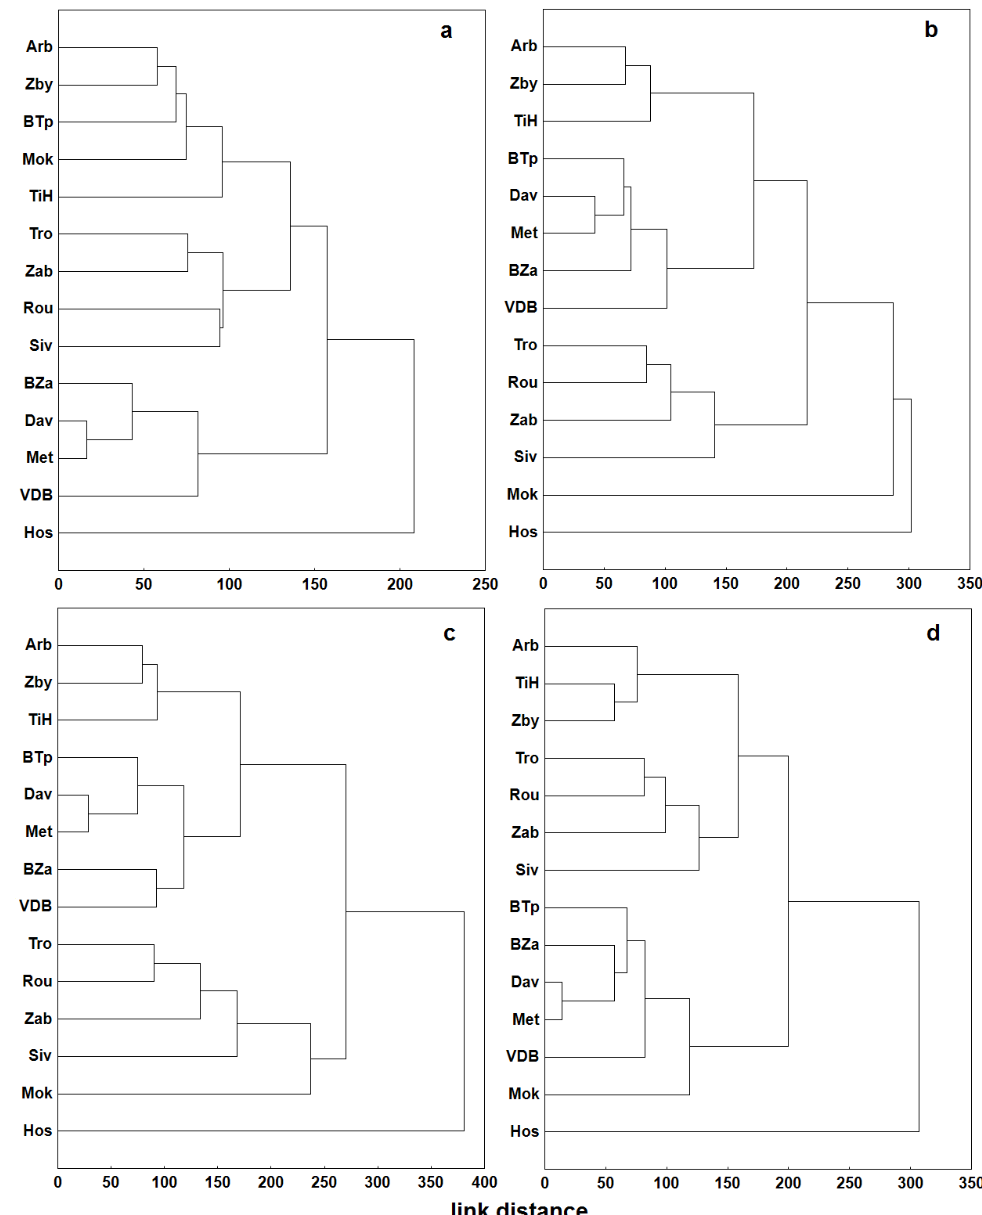
Figure 6. Seasonal ( a —winter, b —spring, c —summer, d —autumn) cluster analysis dendrograms